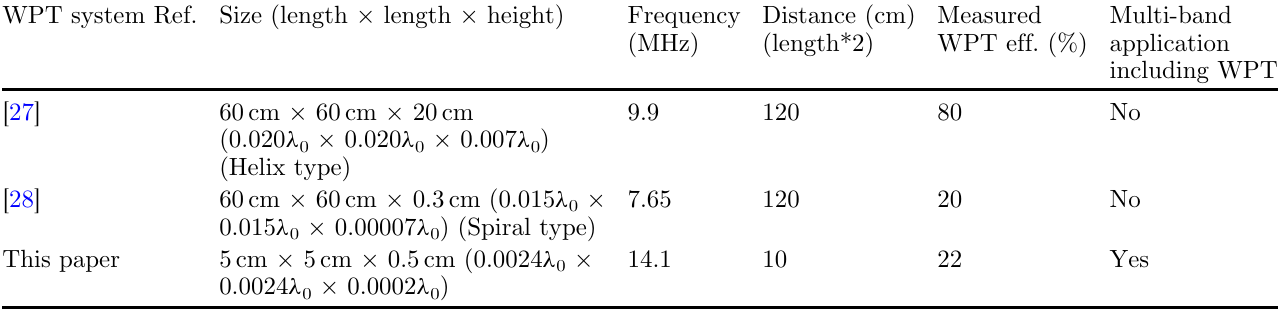
Table 1. Comparison of various resonators for WPT. WPT system Ref. Size (length (cid:3) length (cid:3) height)